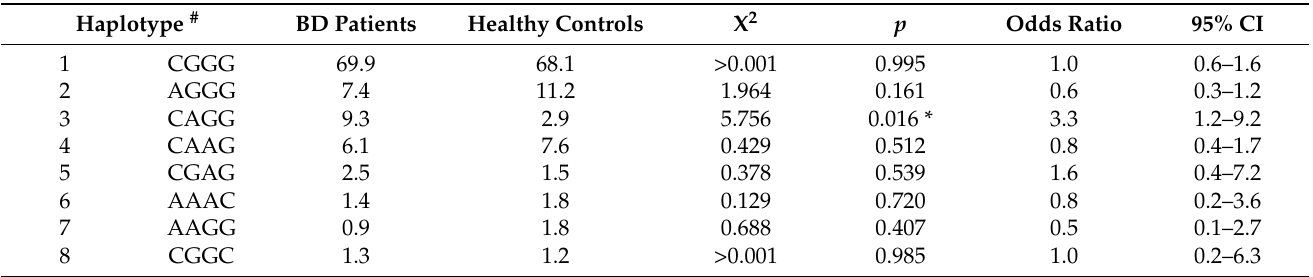
Table 3. Haplotype frequencies of the 4 polymorphisms in the LEPR gene in BD patients and healthy controls.